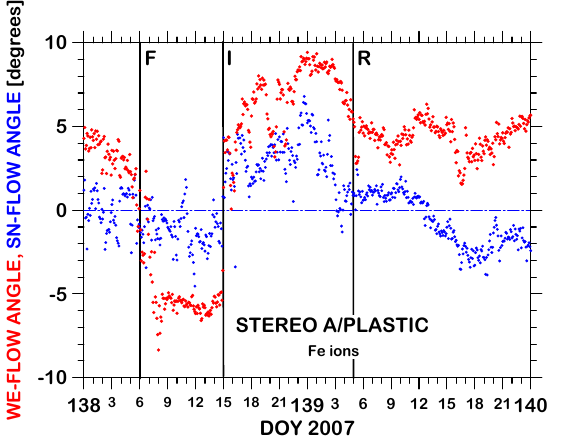
Fig. 1. Flow angles of iron ions in the vicinity of the CIR of 7/8 May 2007 measured with PLASTIC on STEREO/A. The WE-flow angles (red) have not been corrected for aberration effects. The WE- aberration, due to the motion of the spacecraft, is assumed to be 3 ◦ as seen in the undisturbed slow wind early in DOY 127. The SN- deflection angles are shown as blue dots.